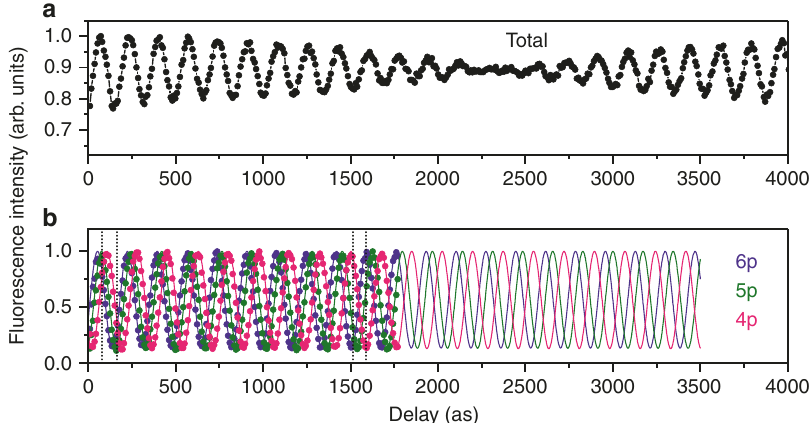
Fig. 3 Intensities of fl uorescent photons from He. Fluorescence intensities are measured as a function of the time delay between the light wave packets: a total fl uorescence in the visible and ultraviolet regions and b contributions from the p-type Rydberg states of n = 4 – 6. The fl uorescence intensities were normalized by the intensities of the undulator radiation and then multiplied so that the maxima become unity. The statistical error of each point in the spectra is in 1 – 2% of the intensity. The total fl uorescence spectrum in a includes a constant background and the baseline is around 0.62 (see supplementary note 1). Delay time of the horizontal axis is measured from the original delay (~2.1 fs) between the light wave packets, thereby, for the absolute time delay, ~2.1 fs has to be added to the present scale. The scale of the time delay was calibrated with the oscillation frequency observed in the spectrum for the 6p Rydberg state. In b , while the experimental values (dots) for the individual Rydberg states were measured until a time delay of 1770 as, the best fi ts to the experimental values with a sinusoidal function convoluted by Gaussian are depicted with solid lines continuing up to a time delay of 3500 as. The time delays chosen for sampling the Rydberg populations plotted in Fig. 4 are indicated in b with vertical lines